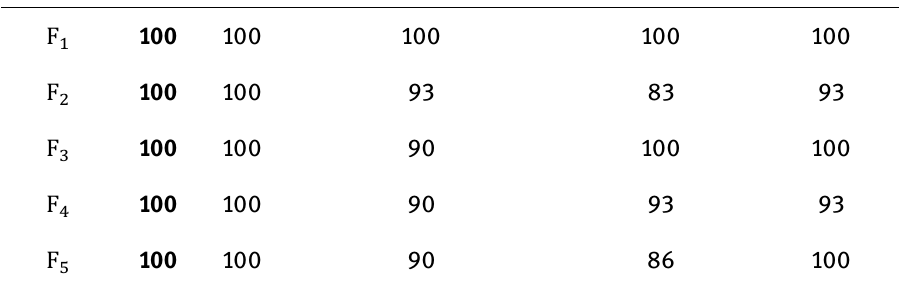
Table 6: Comparison of KGSA, NGSA, deterministic crowding, sequential niche and NichePSO algorithms in terms of %ADR for functions F 1 to F 5 . The results were averaged after thirty independent runs of algorithms.